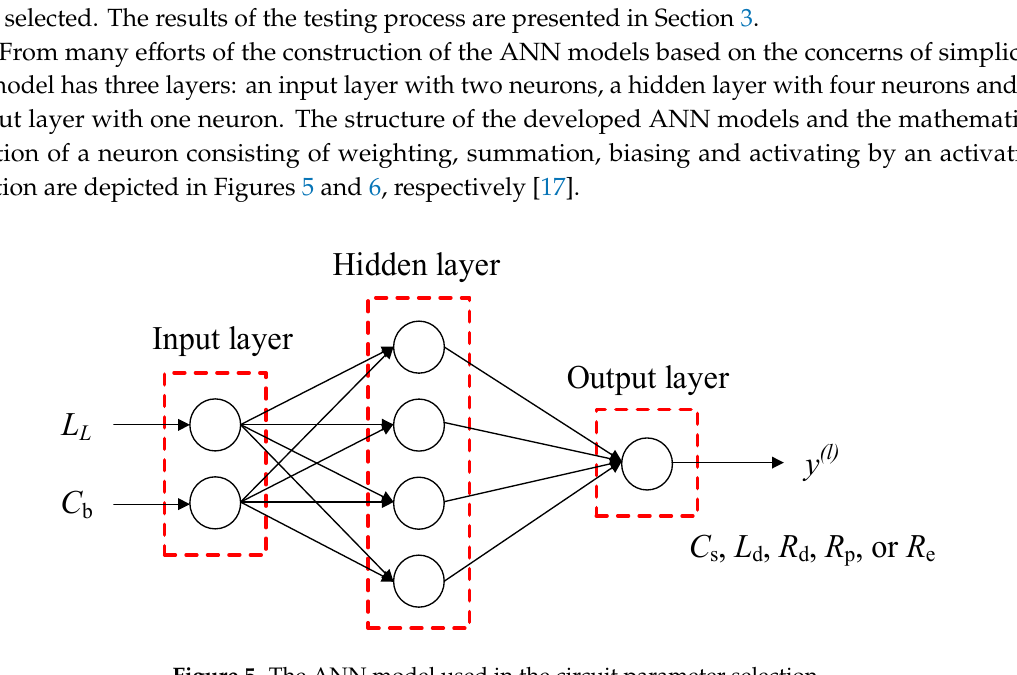
Figure 5. The ANN model used in the circuit parameter selection.